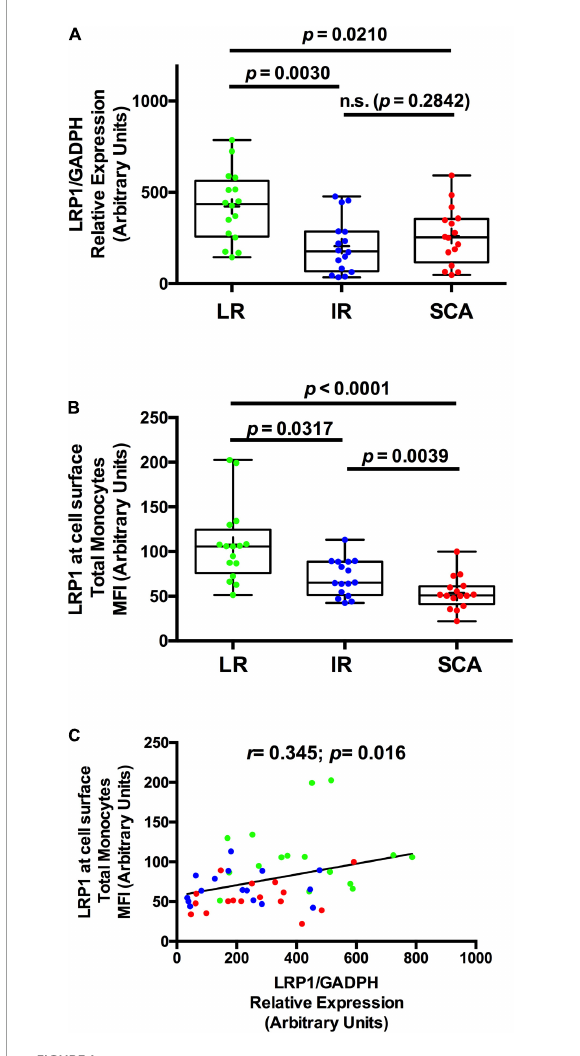
FIGURE1 LRP1 gene expression is also decreased in individuals with SCA and IR. (A) The levels of LRP1 specific transcripts were measured by quantitative RT-PCR (qPCR) in FACS-isolated total monocytes as was described in “Materials and Methods” section and relatively expressed at GAPDH levels from individuals with low risk (LR) (green symbols; n = 16), intermediate risk (IR) (blue symbols; n = 16) and subclinical atherosclerosis (SCA) (red symbols; n = 16) (Study II). (B) The LRP1 expression level at cell surface was measured by flow cytometry assays in total monocytes from peripheral blood extracted of individuals with low risk (LR) (green symbols; n = 16), intermediate risk (IR) of CVD (blue symbols; n = 16), and subclinical atherosclerosis (SCA) (red symbols; n = 16). In (A,B) , results are shown as box plot representing the median value and interquartile range (IQR) of arbitrary units for qPCR and MIF (mean intensity of fluorescence), respectively. Maximal and minimal values for each study group are indicated (bar lines). Parameters were log-transformed to achieve normal distribution and to apply statistical parametric analysis, but in these table the original data were used. (C) Correlation analysis between LRP1 protein and LRP1 mRNA in monocytes of individuals with LR (green symbols), IR (blue symbols) and SCA (red symbols). p -values are shown and differences were considered statistically significant when p <